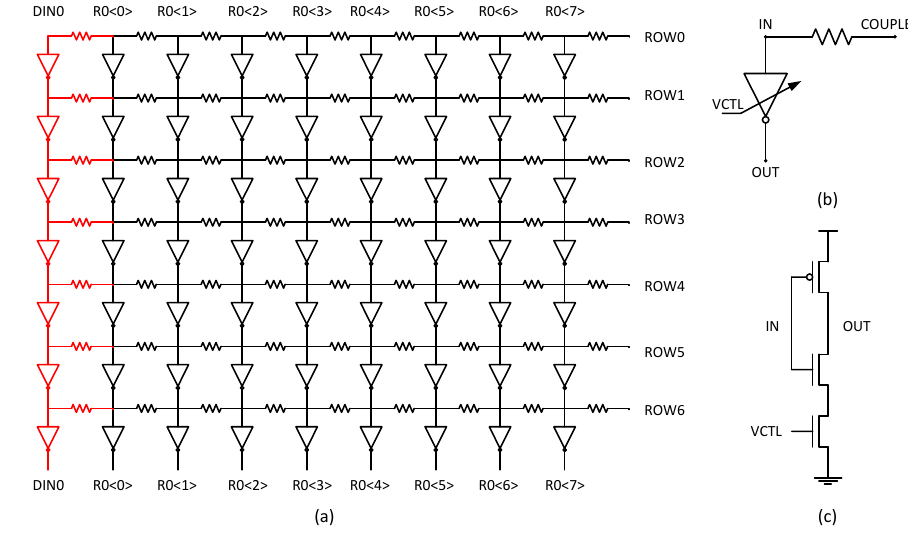
Figure 3. ( a ) RIMC schematic. ( b ) DE schematic. ( c ) Starved inverter schematic. The resistor value, which couples adjacent ring oscillators, is selected in such a way that there are always two DEs switching in consecutive rows (one rising edge and one falling edge) when operating in the typical mode (800 MHz). This avoids any clock duty cycle mismatch between adjacent rows, and it will allow the TDC to obtain time bins smaller than the 20 ps subdelay when combining the phase information of the